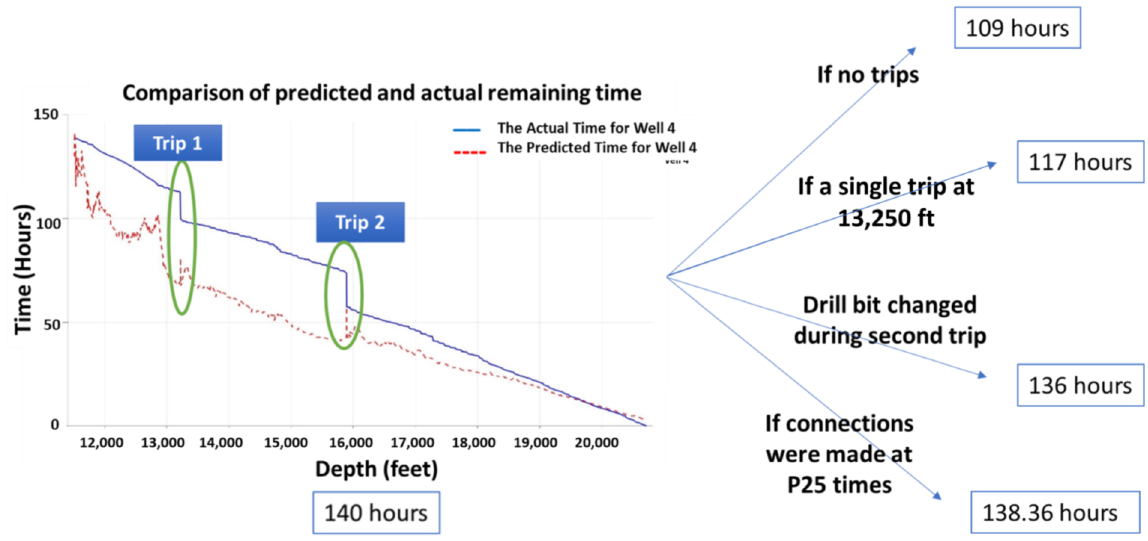
Figure 13. Analyzing post-run ‘what-if’ scenarios. Observations